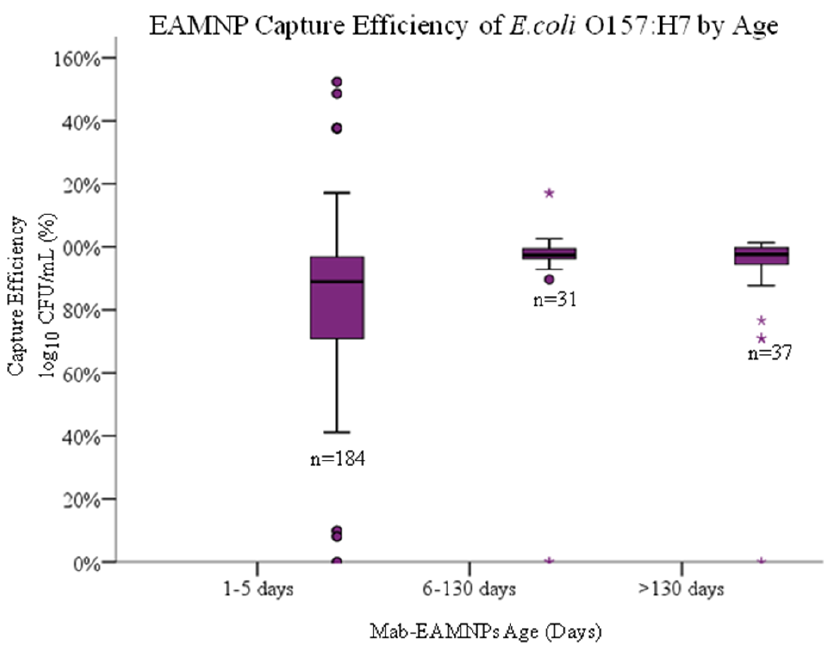
Figure 6. Capture efficiency (log 10 of CFU/mL captured/ log 10 of CFU/mL present) of each E. coli O157:H7 sakai strain captured in IMS, using Mab-EAMNPs, at varying days from conjugation stored at refrigerated temperatures from (1–5 days, n = 184; 6–130 days, n =